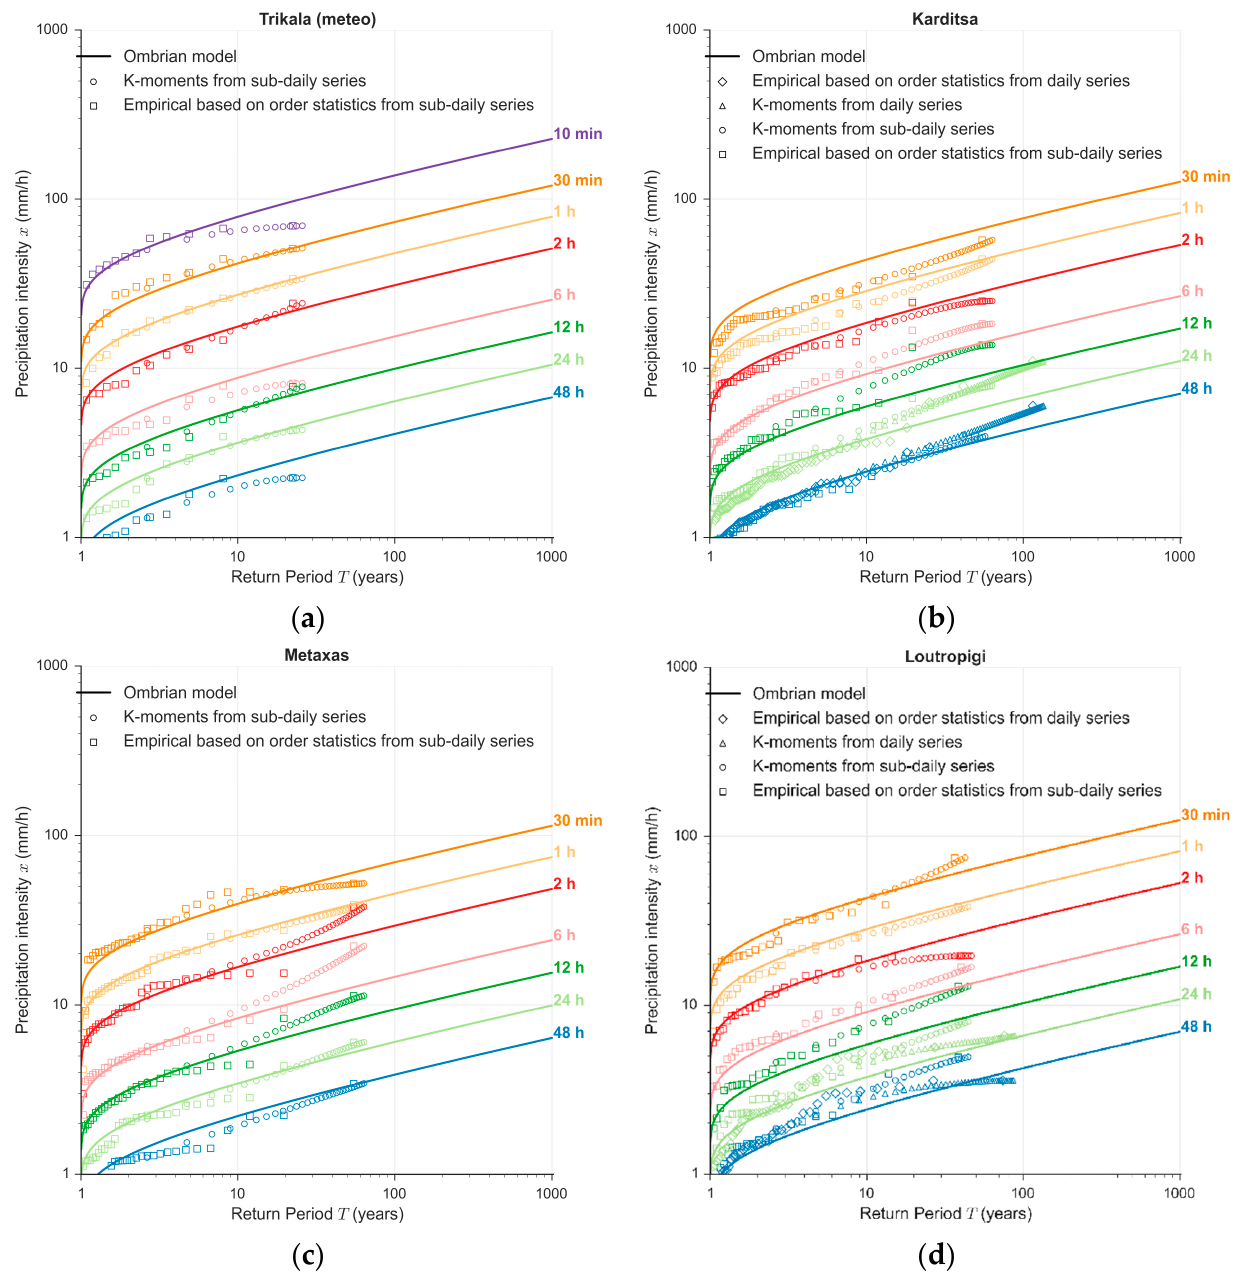
Figure 8. Theoretical and empirical distributions of annual maximum intensities at 10 min to 48 h scales (depending on the available samples) from sub-daily stations of Thessaly’s W.D.: ( a ) Trikala (meteo), ( b ) Karditsa, ( c ) Metaxas and ( d ) Loutropigi. When available the empirical intensities at the 24 h and 48 h scales from the daily raingauges are shown as well. The empirical intensities plotted based on order statistics are also shown for